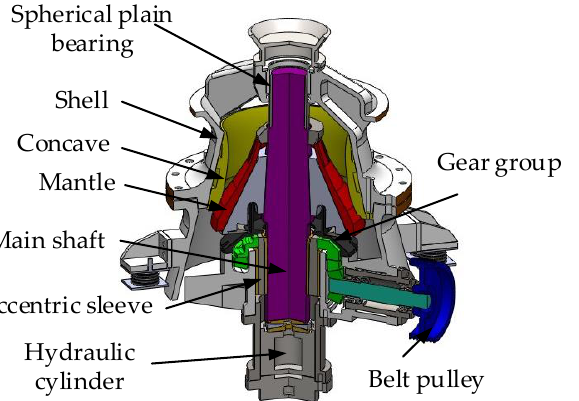
Figure 1. The cross-sectional view of the structure of a hydraulic cone crusher with a single hy- draulic cylinder at the bottom.